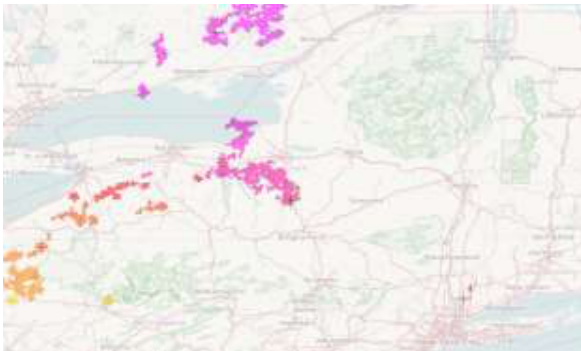
Figure 12. Storm elements for 10Z July 1, 2017 (compare with Figure 10).